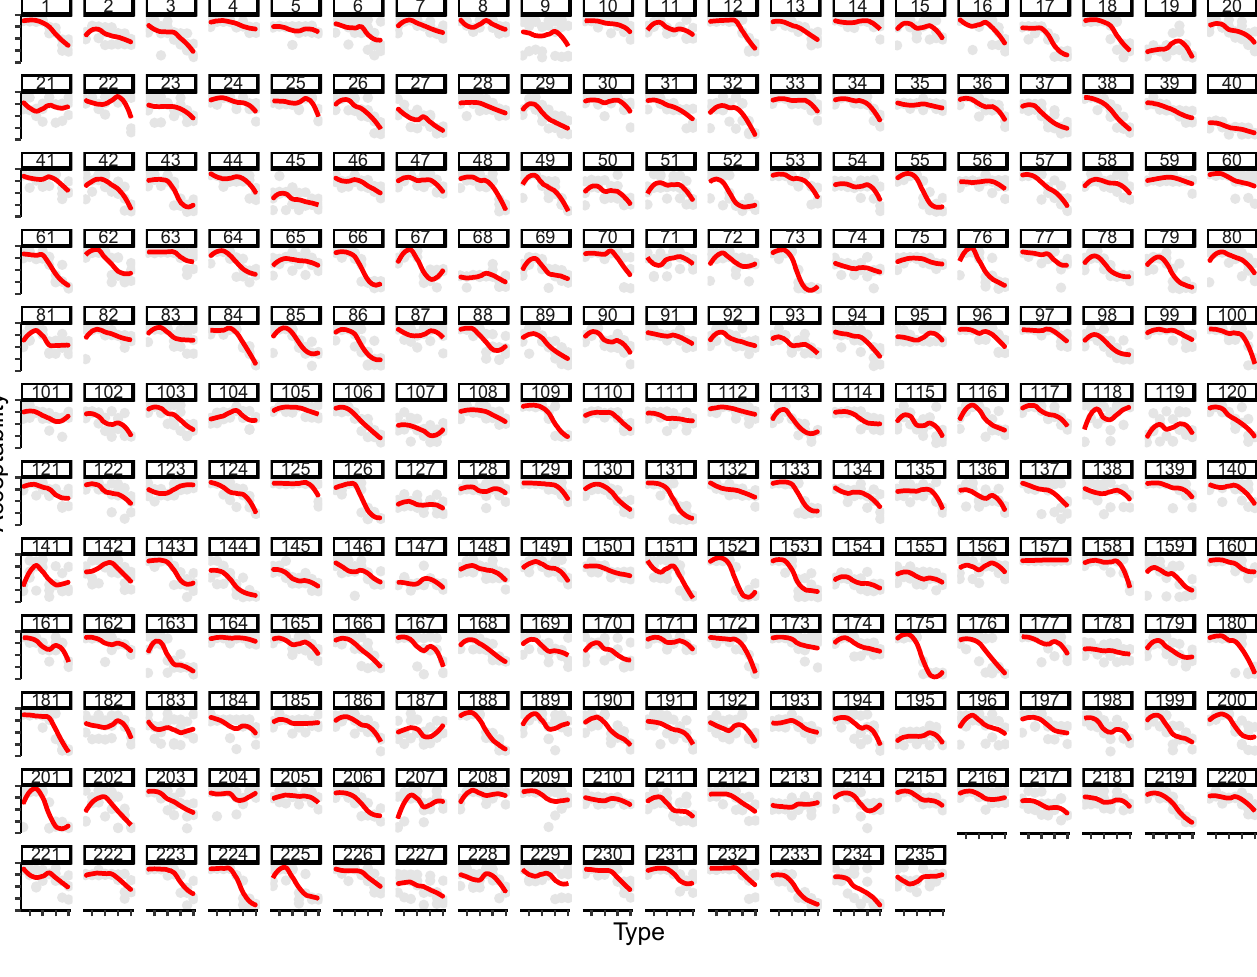
Figure 3. Mean (raw) acceptability ratings by type for each of the 235 participants.